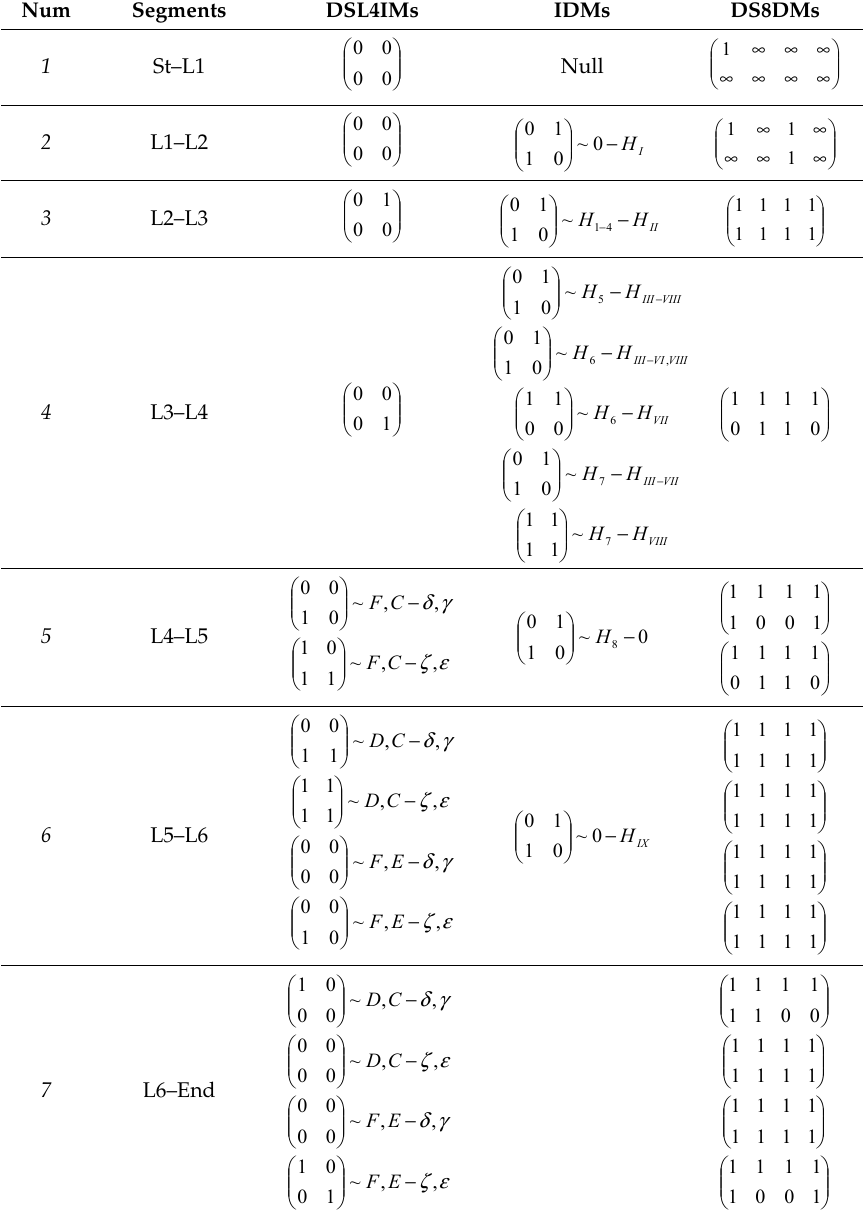
Table 2. The combinatorial reasoning mechanism table.